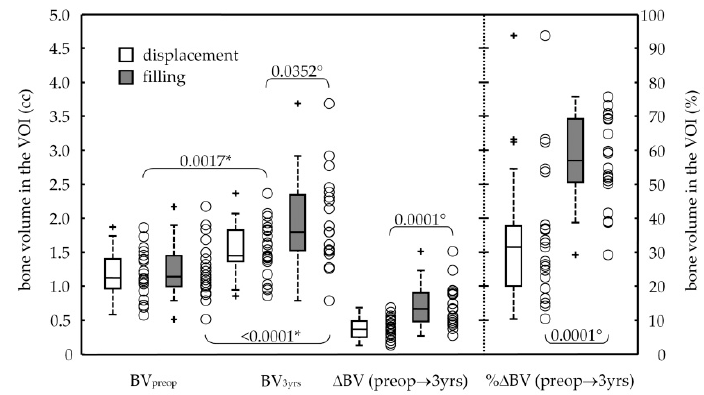
Figure 4. Box and wishers plot (with scattering data, O) of the volume at the preoperative stage (BVpreop) and at the 3 ‐ year survey (BV3yrs) of alveolar bone beneath the sinus, and their difference, ∆ BV (with its percentage, % ∆ BV) from the preoperative stage to the 3 ‐ year survey (preop 3yrs) in volume of interest (VOI). In box ‐ and ‐ whiskers plot the box line represents the lower, median and upper quartile values, the whisker lines include the rest of the data. Outliers (+) were data with values beyond the ends of the whiskers. Results for pair ‐ wise statistical comparisons: Wilcoxon signed ‐ rank test assessing changes in time from the preoperative stage to the 3 ‐ year follow ‐ up (*); Wilcoxon rank ‐ sum test assessing changes between groups (°).4. Discussion.